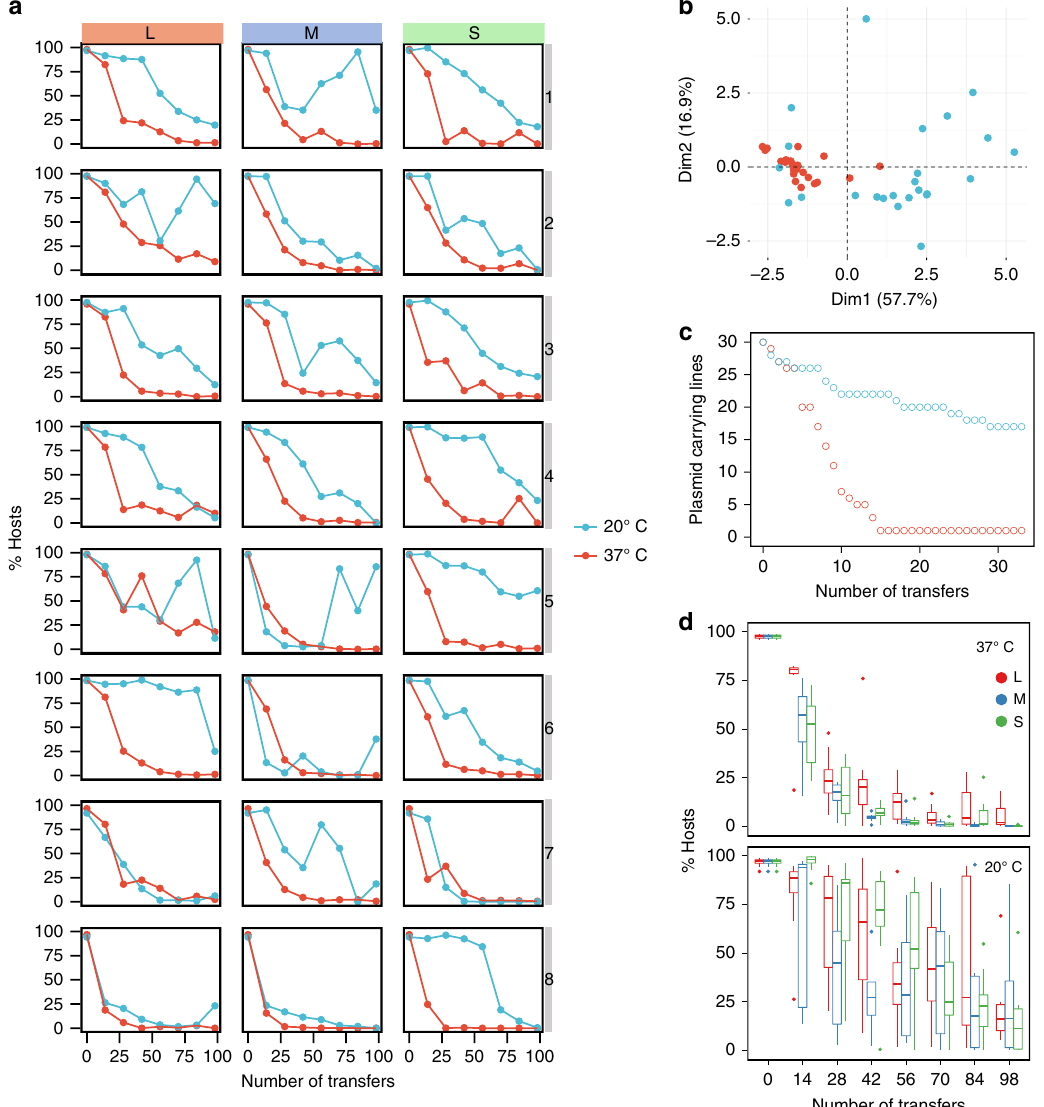
Fig. 1 Evolution of pCON plasmid under non-selective conditions. a pCON persistence is shown as the proportion of hosts during the evolution experiment at 20 °C (blue) and 37 °C (red). The columns correspond to the three population bottleneck sizes (L, M, and S). The experiment was conducted for 98 transfers, which correspond to approximately 600 generations in L populations, 800 generations in M populations, and 1000 generations in S populations. To account for differential growth dynamics, the 37 °C cultures were transferred every 12 h while the 20 °C cultures were transferred every 24 h. The eight replicate lines are presented in vertical order (i.e., populations in each row have a common ancestral population). b Principal component analysis (PCA) of the pCON persistence over time comparing the host dynamics among the temperature regimes. c pCON persistence in the single colony transfer experiment at 20 °C (blue) and 37 °C (red) over a time of 33 transfers corresponding to about 800 generations. d A comparison of variability among pooled replicated lines (for PCA see Supplementary Fig. 3). The evolved lines are pooled according to population bottleneck size. Top: lines evolved at 37 °C. Bottom: lines evolved at 20 °C. The center value of the boxplots represents the median, the boxes denote the interquartile range, and the whiskers represent minimum and maximum values. Source data are provided as a Source Data fi le NATURE COMMUNICATIONS| (2019) 10:2595